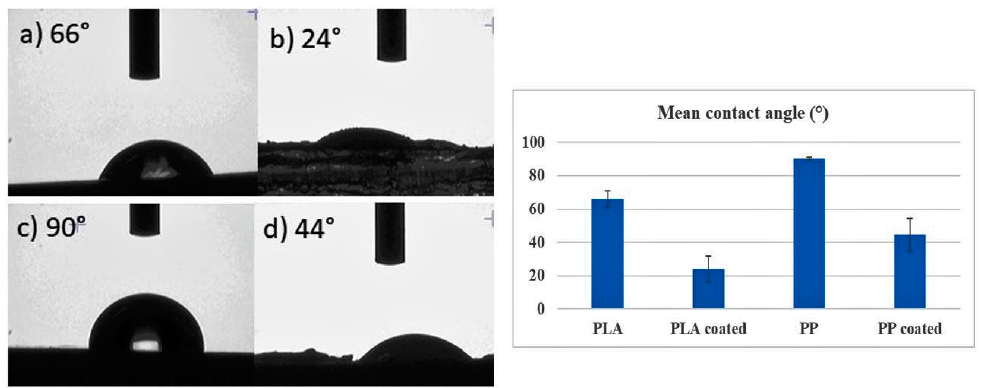
Figure 7. Surface wettability properties of the polymers with and without ZnO coating. With a p -value of 0.001, there is a significant decrease in the contact angle of ZnO@PLA and ZnO@PP when compared to the uncoated PLA and PP films. Water droplet on the surface of ( a ) PLA film, ( b ) ZnO@PLA, ( c ) PP film, and ( d ) ZnO@PP.